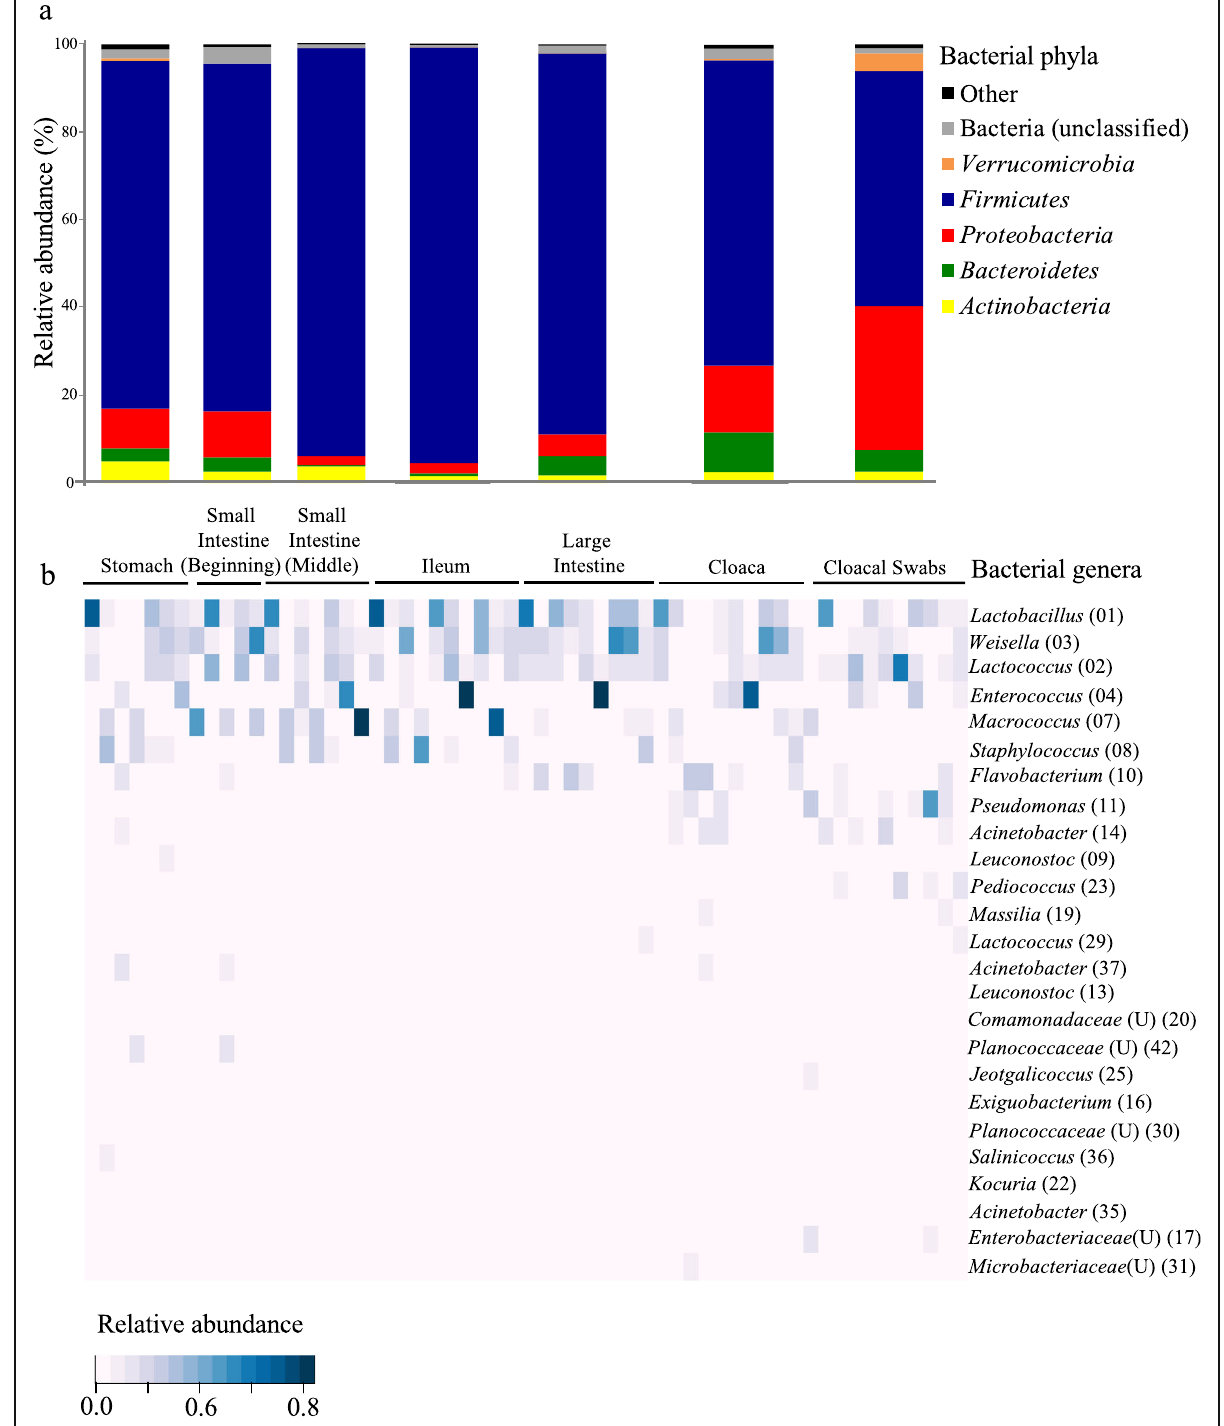
Fig. 2 a Relative abundances of bacterial phyla in different gut sections and cloacal swabs. b Heat map of the relative abundance of the 25 most abundant bacterial OTUs (accounting for a total of 89.5 ± 1.3% (mean ± SE) of sequences in the data set) in different digestive tract regions and cloacal swabs. Genus names provided on the right; U = unclassified genus within the given taxon; OTU numbers given in